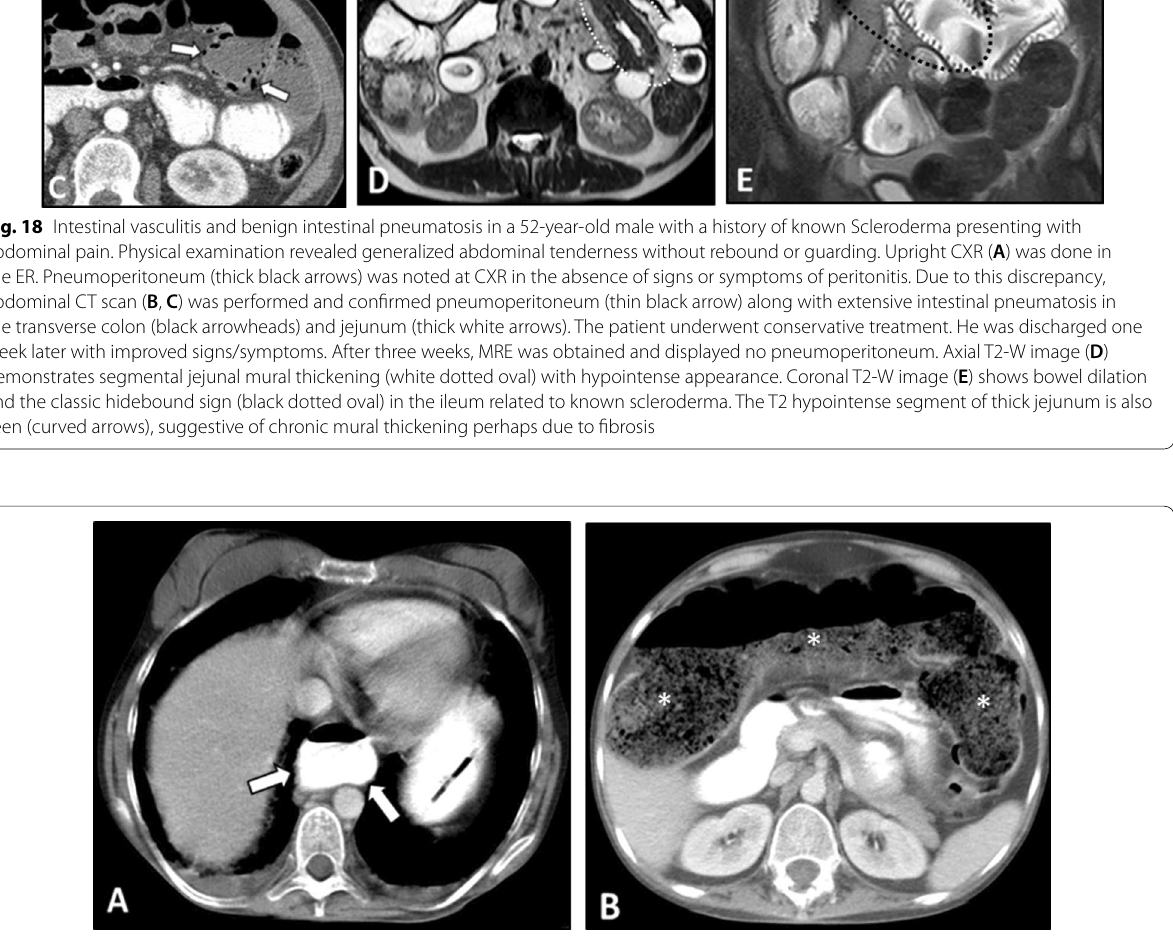
tinal vasculitis [132].